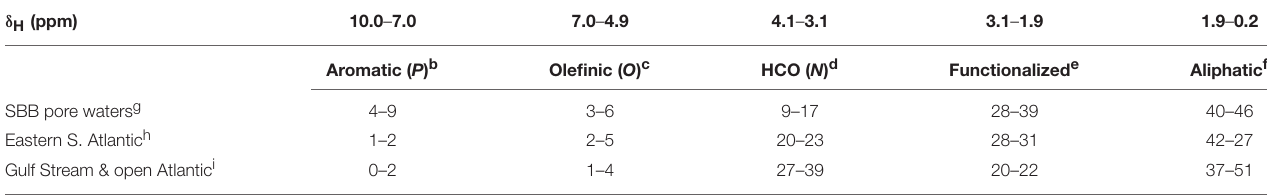
TABLE 1 | Fractional abundances (%) of major 1 H types a . δ H (ppm)